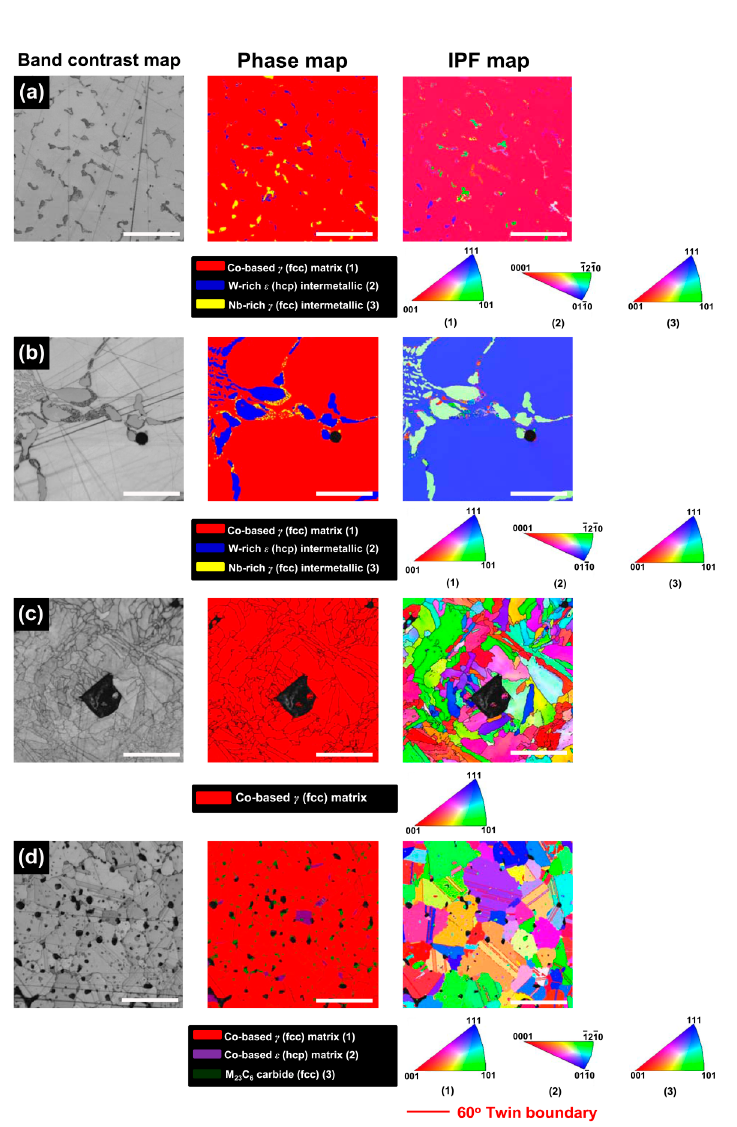
Figure 6. BSE image (band contrast map) for each group and corresponding phase and inverse pole figure (IPF) maps. ( a ) CS; ( b ) ML; ( c ) SLM; and ( d ) ML/PS (500×, scale bar = 50 μ m).